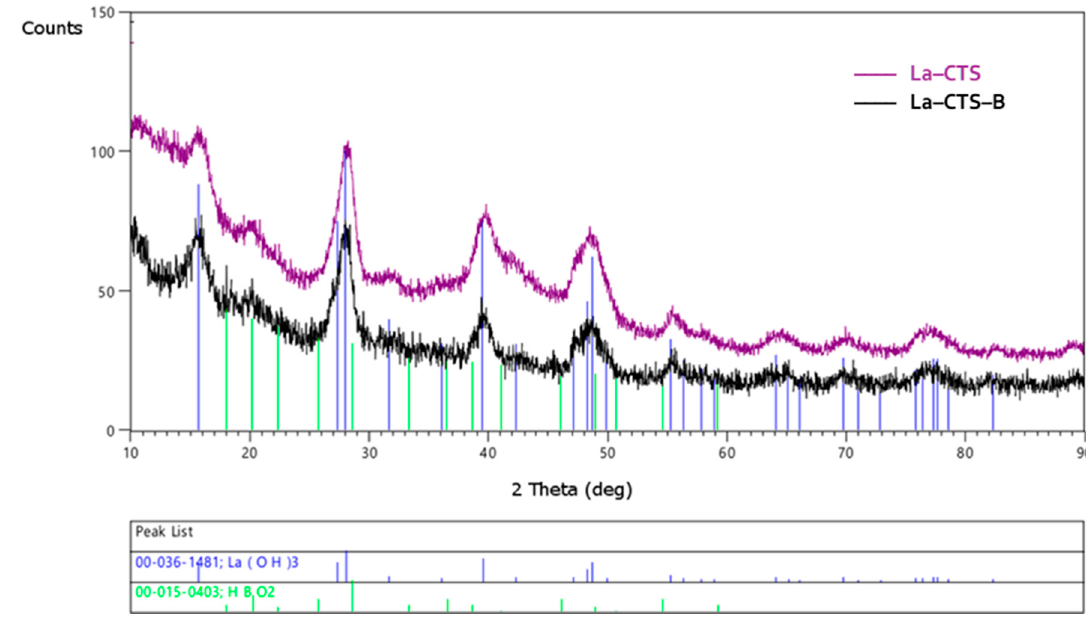
Figure 3. The XRD patterns of the hydrogel beads attached with lanthanum (La-CTS) and hydrogel beads attached with lanthanum after boron adsorption (La-CTS-B).